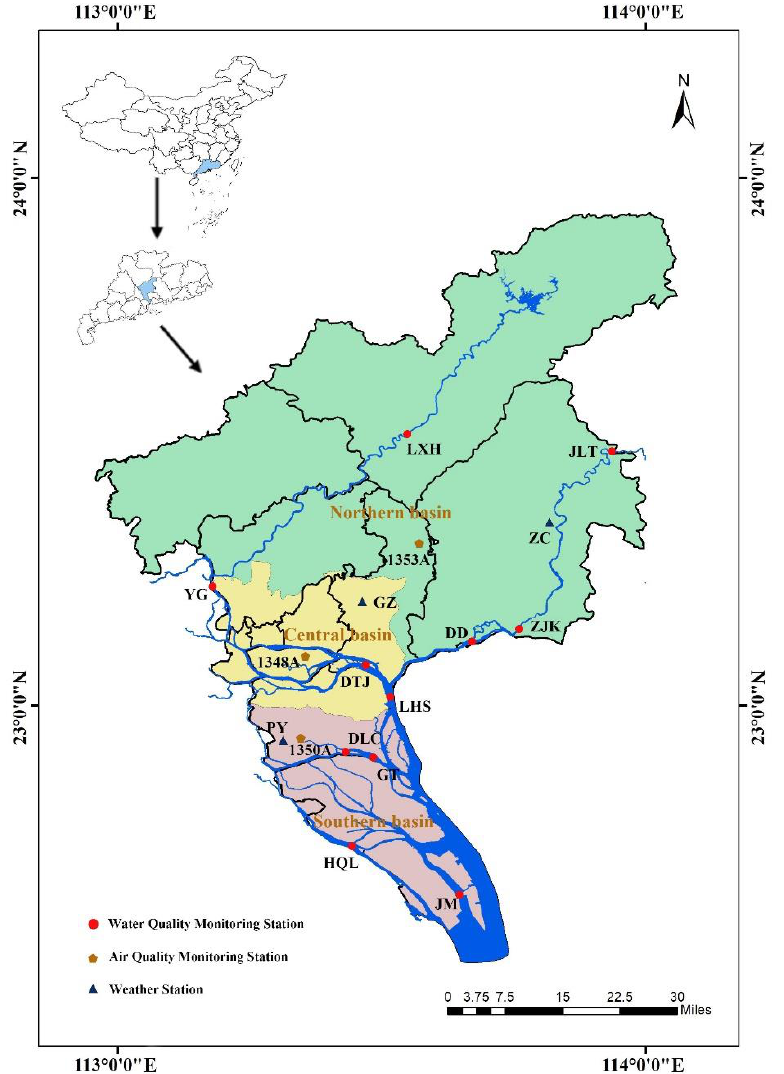
Figure 1. Distribution of river basins and monitoring stations in the Guangzhou reach of the Pearl River.